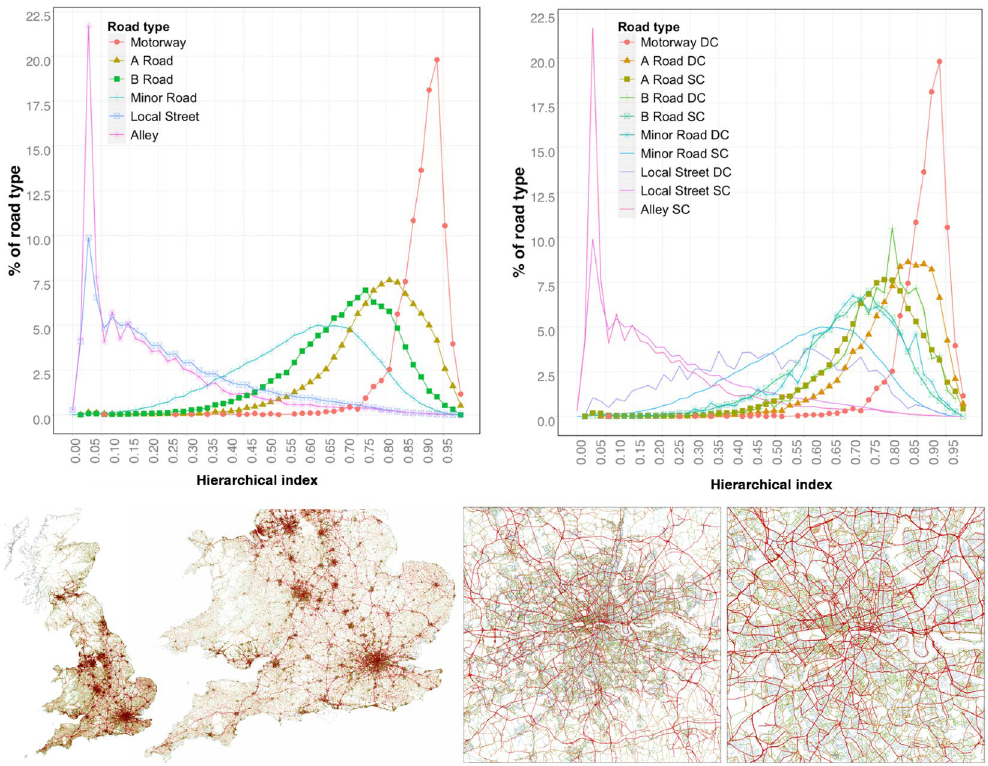
Figure 3. UK’s road network at different scales where the thickness of the lines and the color scale correspond to the values of the hierarchical index as calculated using Equation